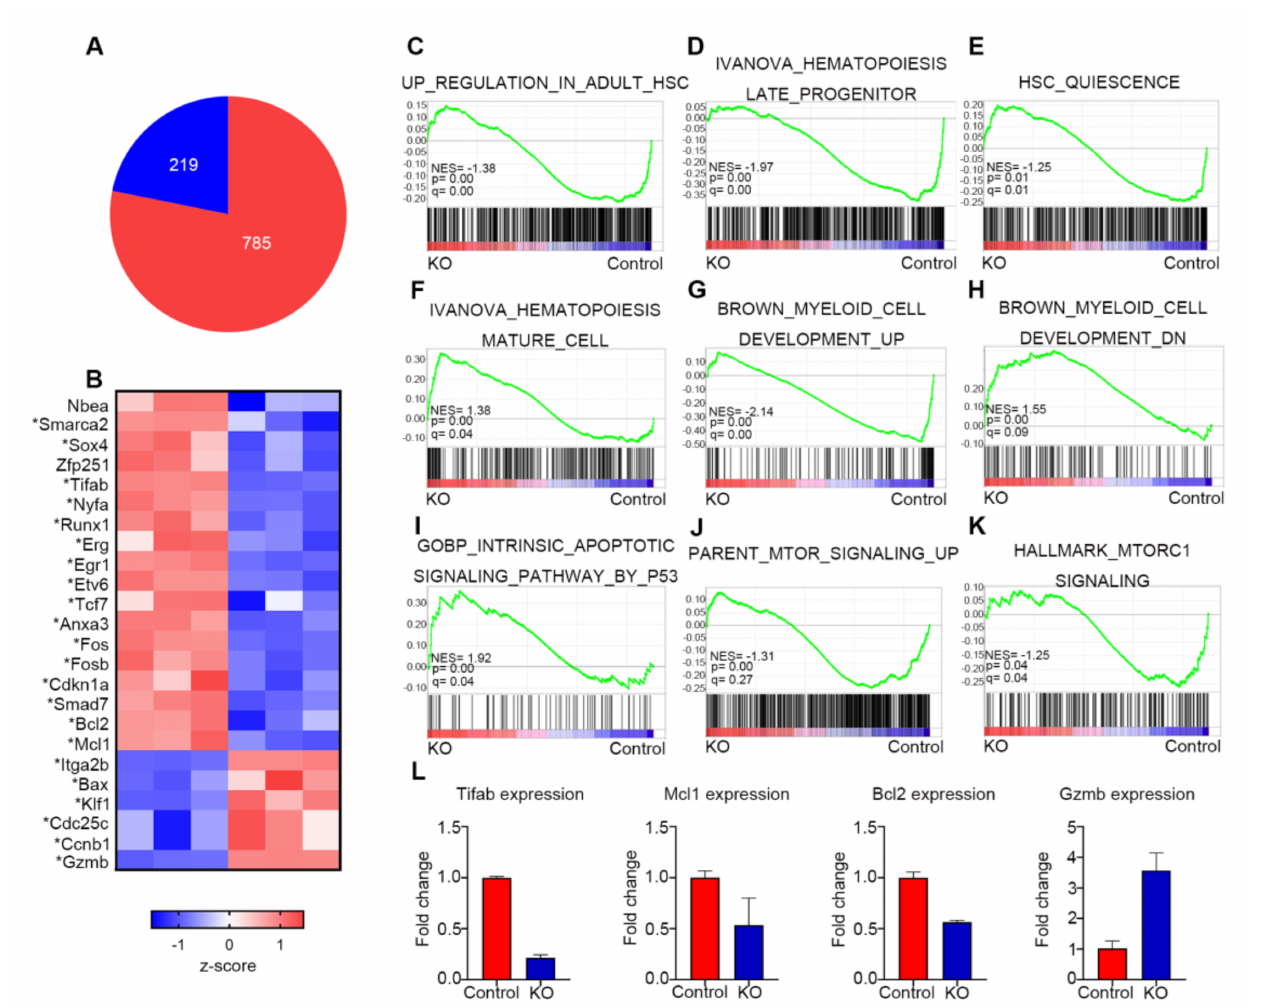
Figure 6. Myh9 deletion alters expression of genes responsible for HSC maintenance. ( A ) Pie chart showing the numbers of differentially expressed genes in Myh9 -deficient LSK cells 4 days after first poly I:C injection. ( B ) Heat map showing interested genes involved in regulation of HSC self-renewal, survival, and maintenance. Genes with * are significantly up- or down- regulated. ( C – K ) Gene set enrichment analysis showed significant alterations of genes related to hematopoietic stem cells, myeloid cells, survival, and mTOR signal pathways in Myh9 fl/fl :Mx1-cre LSK cells compared with control LSK cells 4 days after first poly I:C injection. ( L ) Expression level of genes from selected gene sets were confirmed by real time PCR (n = 3). Data are shown as mean ±